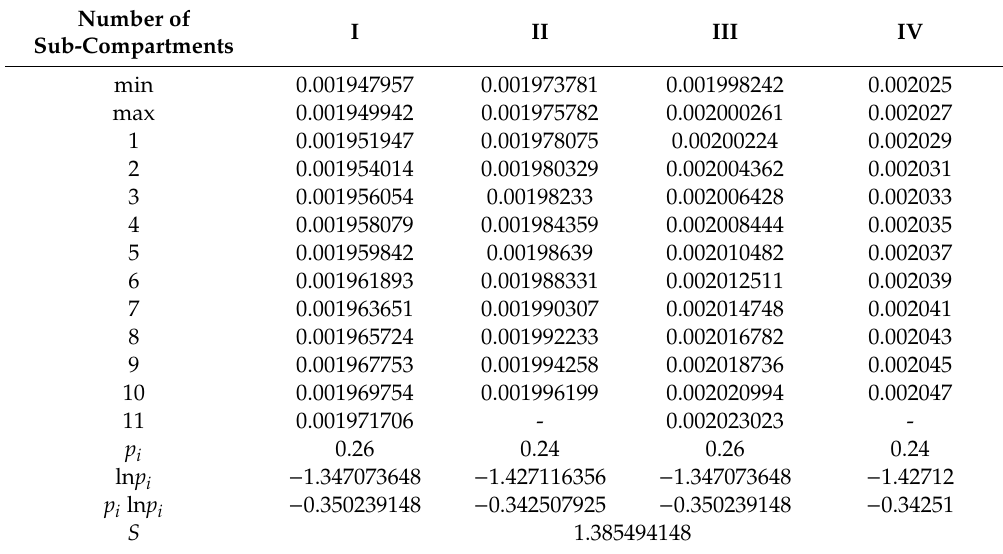
Table 3. Procedure of computing the K-S metric entropy from simulated data. Number